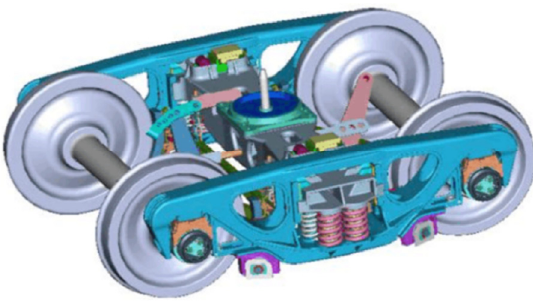
Figure 7. 3D view of the bogie [33].